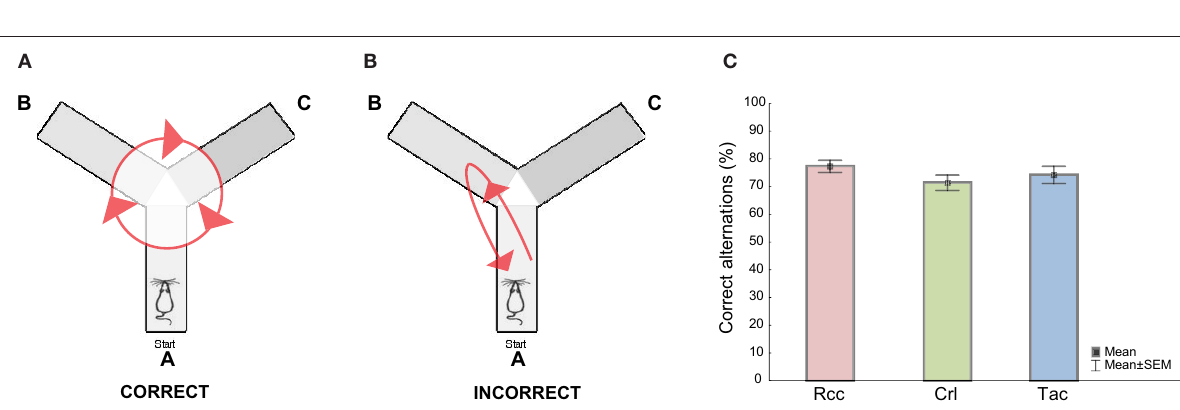
FIGURE 1 | The experimental outline. The rats were allowed to acclimatize to the animal facility and the reversed light/dark cycle for 2 weeks and adapted by daily handling. Thereafter, the animals were tested in the open field (OF) followed by the Y-maze and then given intermittent access to alcohol and water in the home cage on 3 consecutive days per week for 6 weeks. Subsequently, over the next 4 weeks naltrexone (NTX) and saline were administered in a Latin square design 30min prior to alcohol access and intake was measured at 30min, 2h, and 24h.